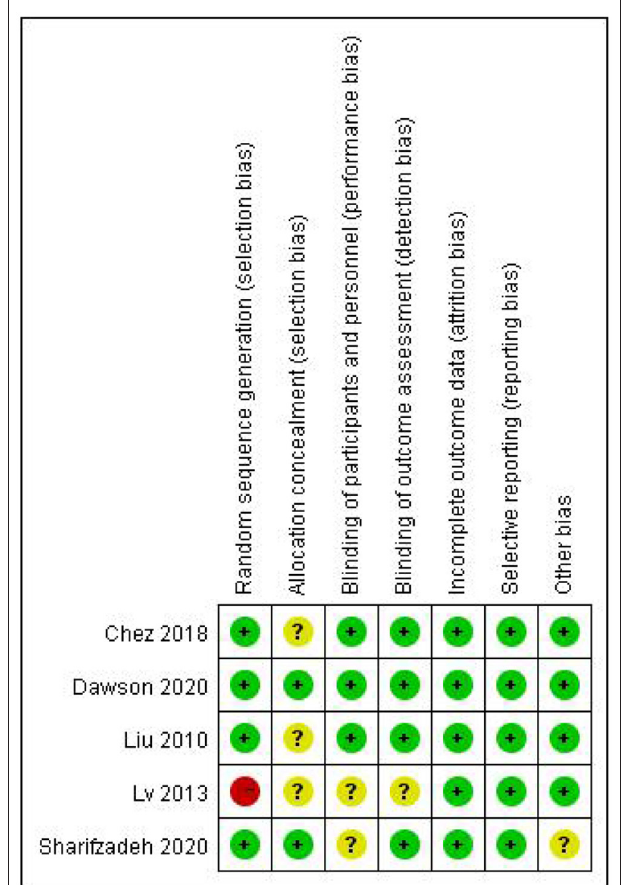
FIGURE 3 | Risk of bias and applicability concerns.